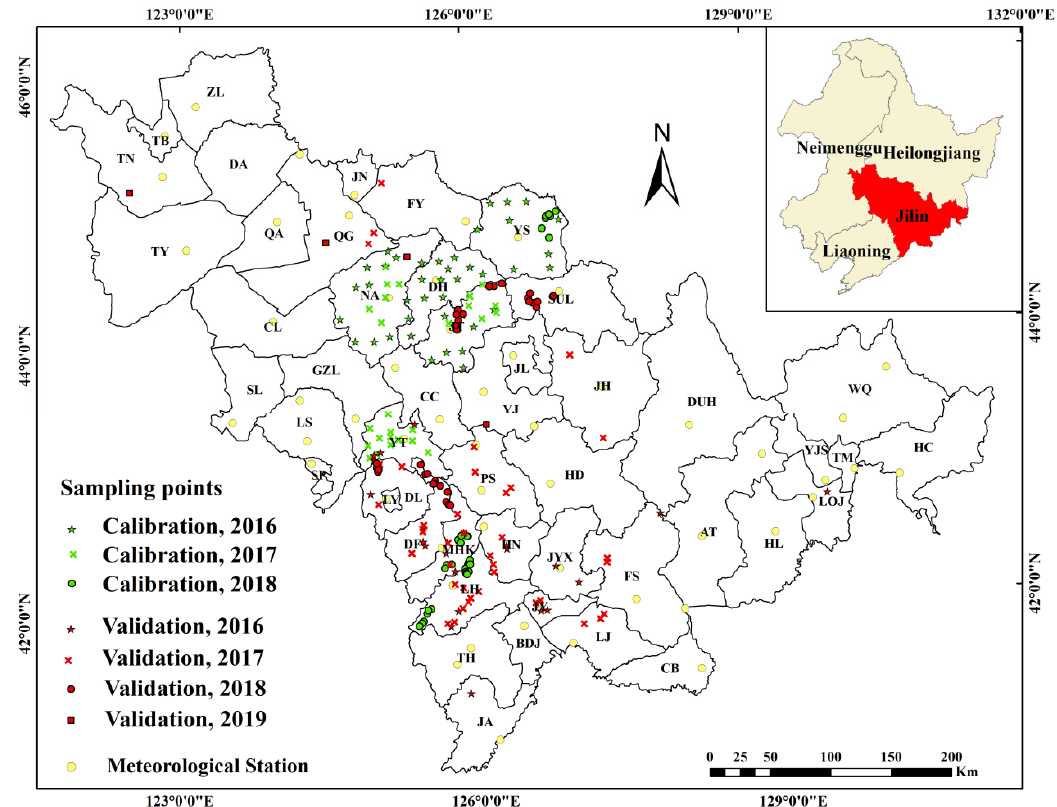
Figure 1. Location of Jilin Province, sampling site, and weather station.